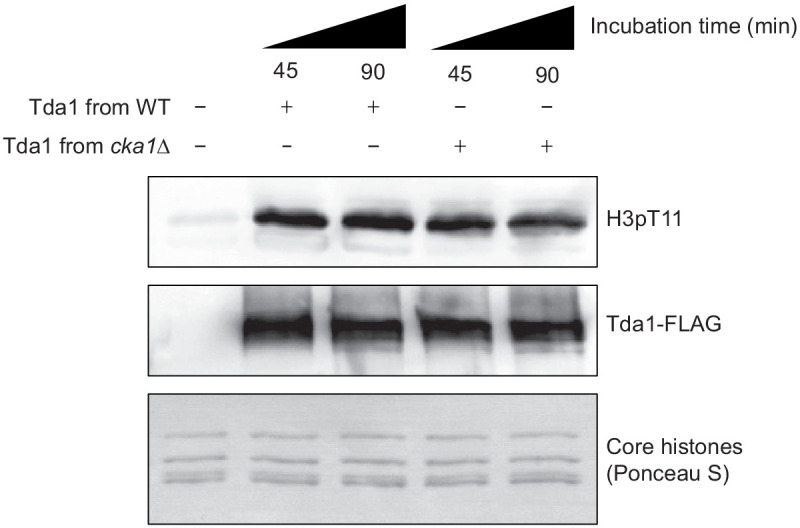
CK2 does not regulate Tda1 activity.In vitro kinase assay of yeast FLAG-tagged Tda1 purified from WT or cka1Δ background. Core histones were used as substrates. The reaction mixtures were incubated at 30°C for indicated times.